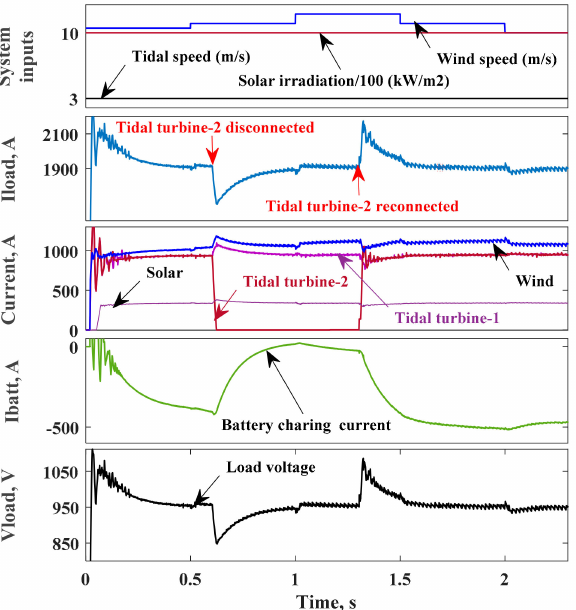
Figure 19. Case-d: performance of a single floating energy unit at the fault of tidal